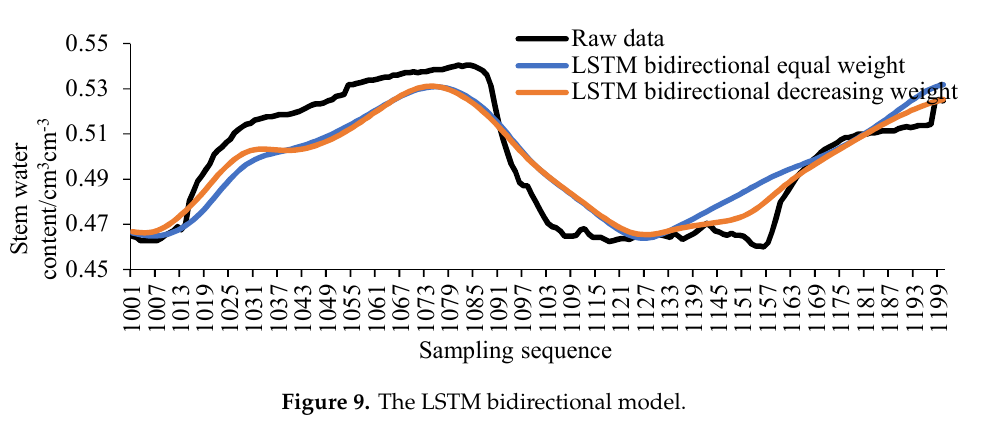
Figure 8. The LSTM unidirectional model.